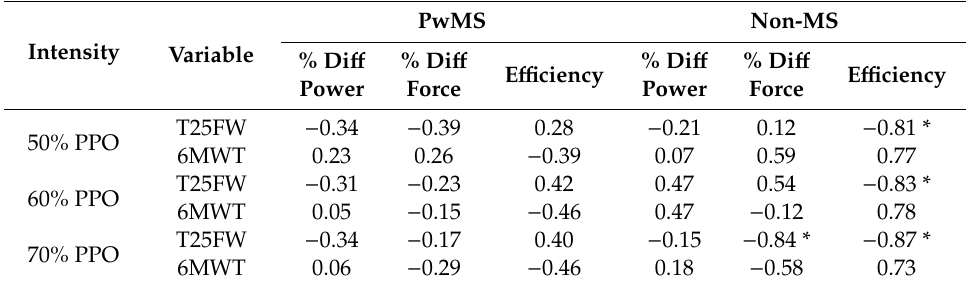
Table 5. Correlation coefficients between walking performance and physiological variables from the submaximal increment cycling test.